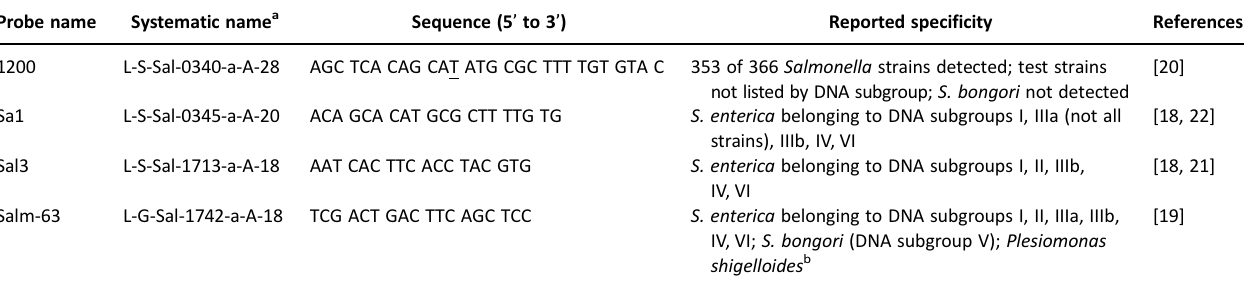
Table 1 . Names, sequences and reported specificities of probes used in this